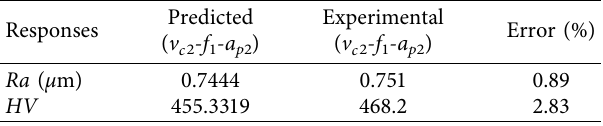
Table 11: Confirmation of optimization